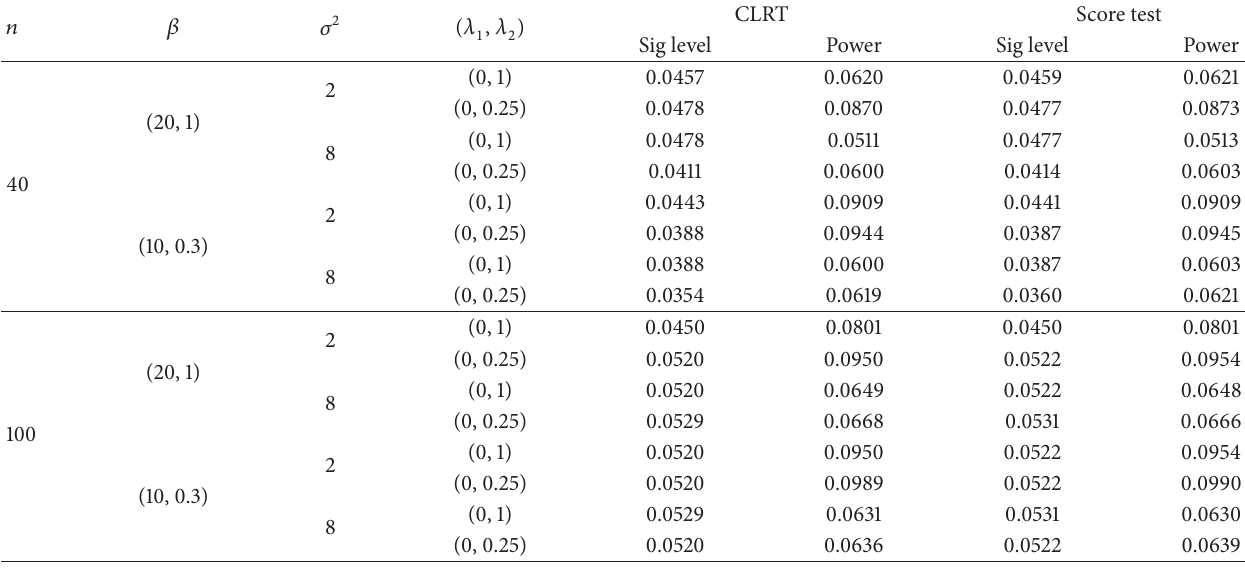
Table 1: The probability of a type Ι error ( 𝛼 = 0.05 ) and power of CLRT and score test statistics for a variance shift model in a linear measurement error with combination different of parameters 𝛽 , 𝜎 2 , Λ , and 𝑏 = 1 .